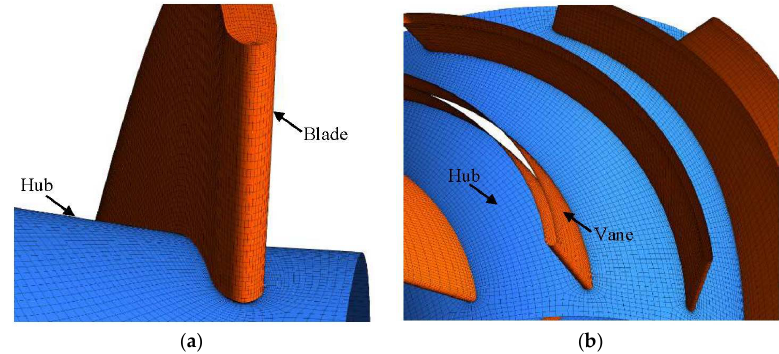
Figure 2. Meshes of impeller and diffuser. ( a ) Impeller; ( b ) diffuser.